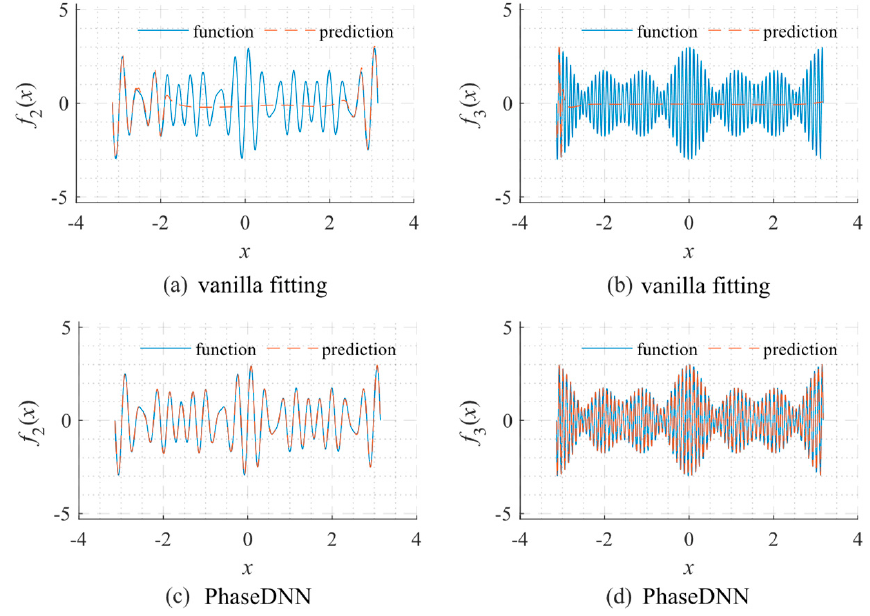
Figure 3. Comparison between the fitted results using the PhaseDNN method and vanilla fitting when N = 1000. The objective functions for fitting: f 2 = sin17 x + sin19 x + sin23 x and f 3 = sin67 x + sin71 x + sin73 x . ( a ) Fitting f 2 via vanilla fitting; ( b ) fitting f 3 via vanilla fitting; ( c ) fitting f 2 via PhaseDNN; and ( d ) fitting f 3 via PhaseDNN. The network used a 1-40-40-40-40-1 fully connected structure type. The Adam optimizer was used for optimization under the default learning rate.